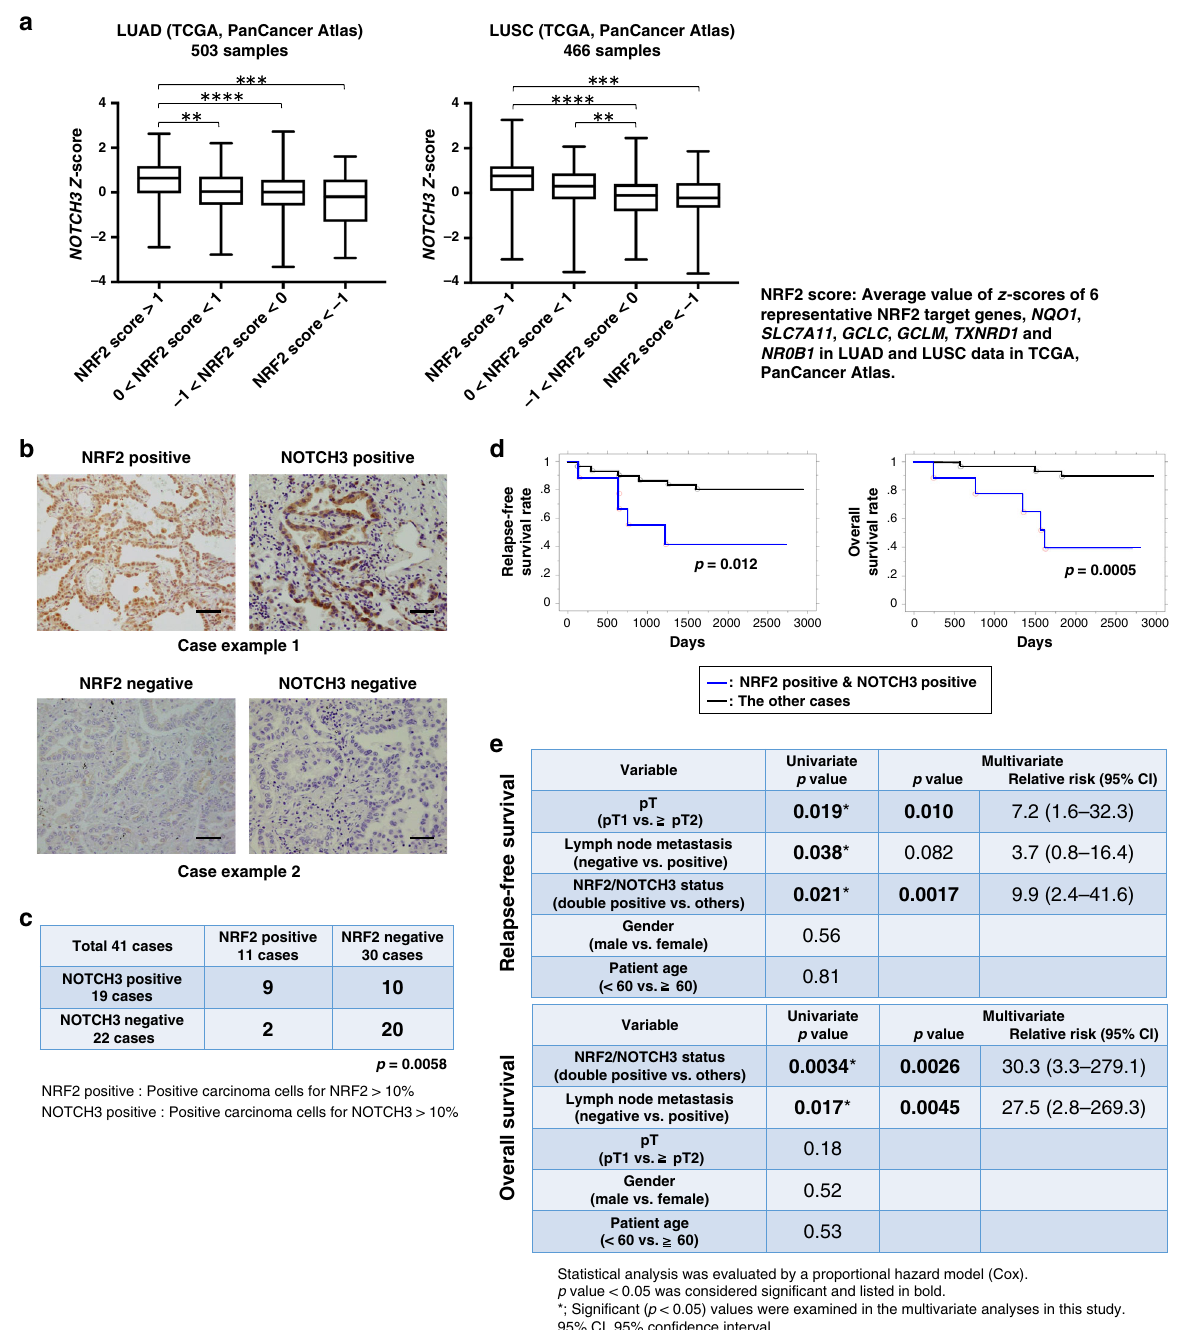
Fig. 2 The NRF2-NOTCH3 axis is associated with poor clinical outcomes in lung adenocarcinoma patients. a NOTCH3 mRNA expression in tumor tissues strati fi ed according to NRF2 activities. Gene expression data for lung adenocarcinoma (LUAD) and squamous cell carcinoma (LUSC) patients were obtained from the TCGA database. Box plots are de fi ned by the 25th and 75th percentiles. Center line represents the median (50th percentile). Whiskers indicate minimum and maximum values. One-way ANOVA followed by the Bonferroni post hoc test was performed. ** p < 0.01, *** p < 0.001, **** p < 0.0001. b Immunostaining for NRF2 and NOTCH3 in human lung adenocarcinoma tissues. Representative cases with high and low expressions of NRF2 and NOTCH3 from two independent experiments are shown. Scale bar correspond to 50 μ m. The same cases are shown in Fig. 7c. c Association between NRF2 and NOTCH3 statuses in 41 lung adenocarcinoma patient samples. The Chi-square test was conducted to determine statistical signi fi cance. p = 0.0058. d Overall survival rates and relapse-free survival rates for post-surgery patients grouped into NRF2 and NOTCH3 double-positive cases and the remaining cases. Kaplan-Meier analysis was conducted. Statistical signi fi cance was evaluated using the log-rank test. p = 0.012 for relapse-free survival, p = 0.0005 for overall survival. e Univariate and multivariate analyses of 41 lung adenocarcinoma patients. The Cox proportional hazards model was